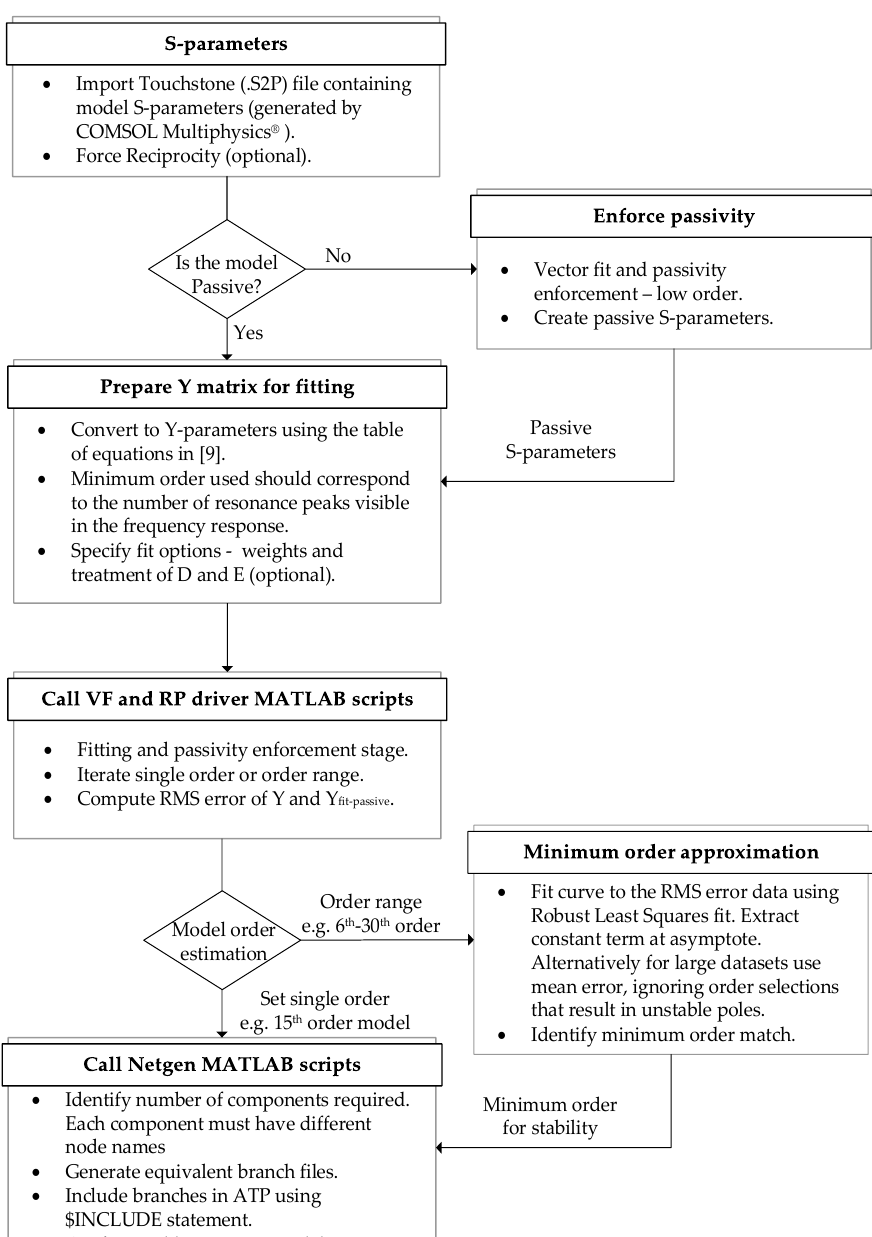
Figure A1. Algorithm for pole-residue model generation and determination of the minimum order of